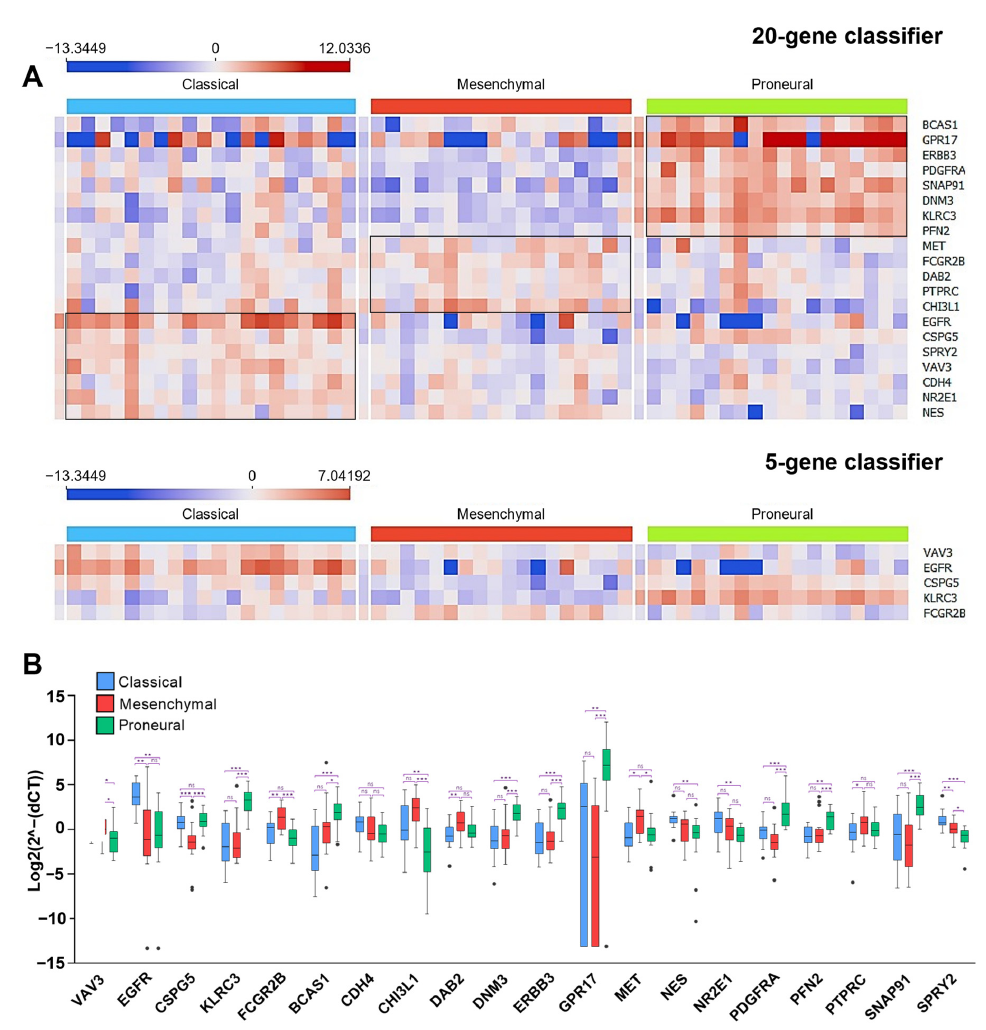
Figure 6. ( A ) Selected gene expression profiles between different subtypes in the LUHS cohort. Specimens are classified according to the 20-gene model (upper) and five-gene model (below). ( B ) Boxplot demonstrates gene expression differences between subtypes in the LUHS cohort (classified based on the 20-gene model). Asterisk indicates significance level: *— p < 0.05, **— p < 0.01, ***— p < 0.001.